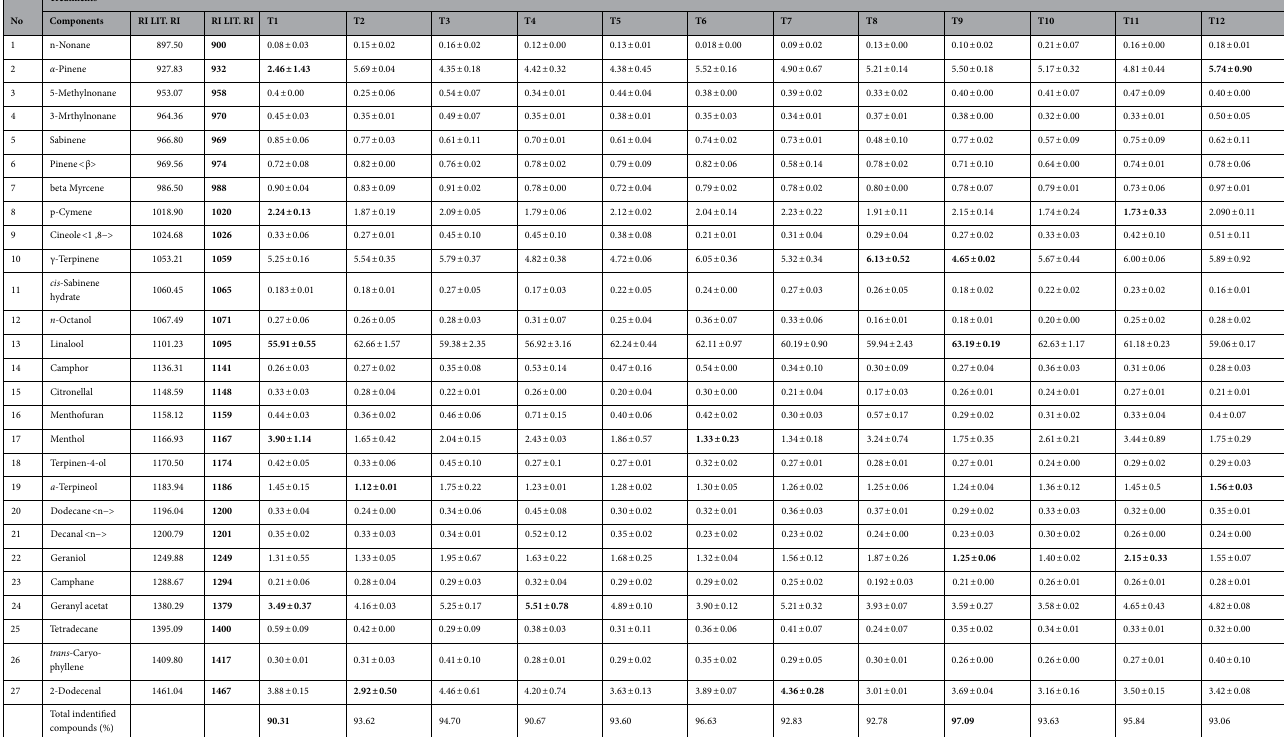
Table 2. Composition of the coriander essential oil influenced by the organic and chemical fertilizers × humic acid application (average of 2 years). Significant values are in bold. T1 without fertilizer × without HA (control), T2 without fertilizer × HA before flowering, T3 without fertilizer × HA at beginning of flowering, T4 vermicompost × without HA, T5 vermicompost × HA before flowering, T6 vermicompost × HA at beginning of flowering, T7 Livestock manure × without HA, T8 Livestock manure × HA before flowering, T9 Livestock manure × HA at beginning of flowering, T10 chemical fertilizer × without HA, T11 chemical fertilizer × HA before flowering, T12 chemical fertilizer × HA at beginning of